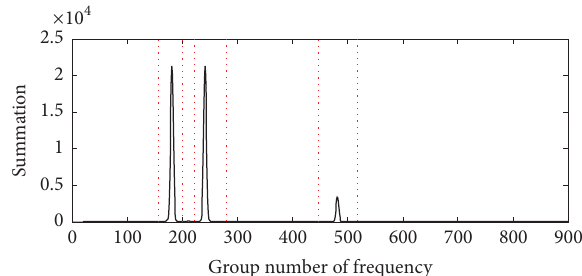
Figure 8: The different frequency-group summations of the time-frequency panel of the sample signal.